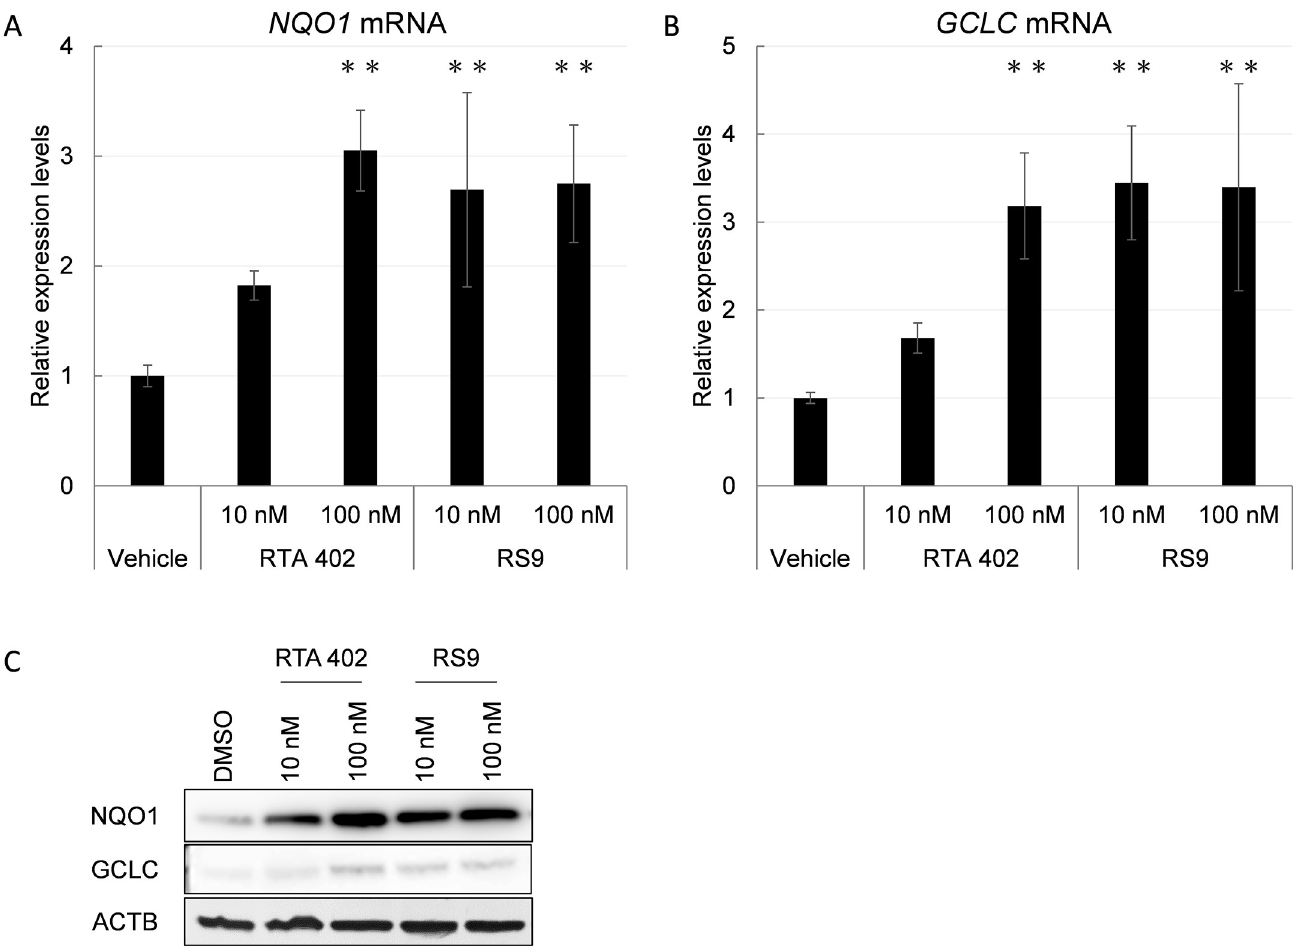
Fig 1. NFE2L2-targeted gene activation in HCE-T cells by RTA 402 and RS9. A, RT-qPCR analysis of NAD(P)H dehydrogenase , quinone 1 ( NQO1 ) mRNA and B, Glutamate-cysteine ligase catalytic subunit ( GCLC ) mRNA in HCE-T cells treated with RTA 402 and RS9. HCE-T cells were treated with 10 nM and 100 nM of RTA 402 and RS9 for 48 hours. Relative mRNA expression levels were calculated relative to vehicle-treated samples. RS9 induced NQO1 and GCLC mRNA expressions at a lower concentration compared with RTA 402. Data are presented as the mean ± SD (N = 4). �� P < 0.01 compared with vehicle, Dunnett’s test. C, Western blot analysis of NQO1 and GCLC in HCE-T cells treated with RTA 402 and RS9. Whole cell lysates were collected after 48 hours treatment of RTA 402 or RS9. ACTB was detected as internal control. Western blot data confirmed NQO1 and GCLC inductions at protein levels. Representative data were shown (N = 2).